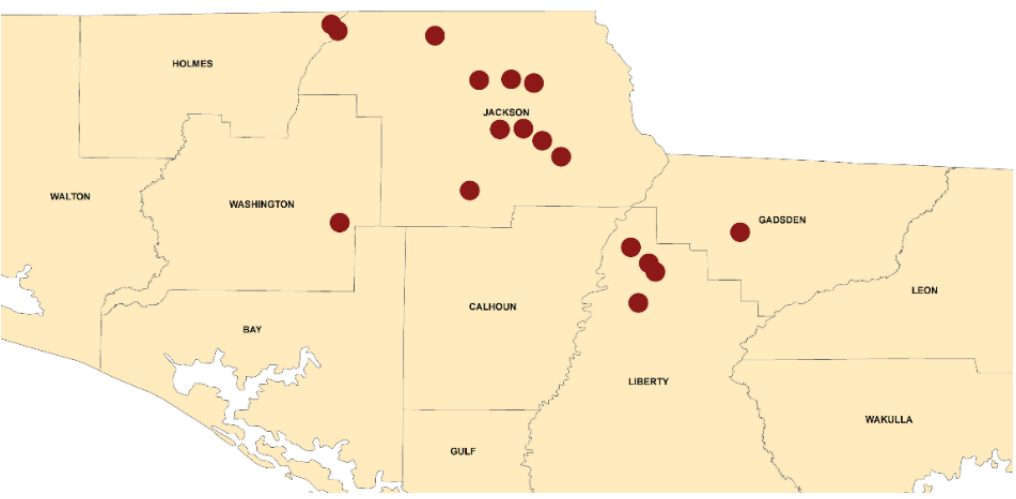
Figure 1. Active locations of Ips bark beetle infestations occurring in 2019 used for analysis as red dots (geolocation data provided by Florida Forest Service). Florida county names are listed. Table 1. Counties and dates of aerial survey detection for active Ips bark beetle infestations occurring in 2019 in the Florida Panhandle (data form Florida Forest Service). Latitude, longitude, stand type, total stand area, average diameter at breast height (DBH), approximate area infested with bark beetles, and tree species information is provided. Spot detection in MODIS (Moderate Resolution Imaging Spectroradiometer) and Sentinel2 satellite images noted.